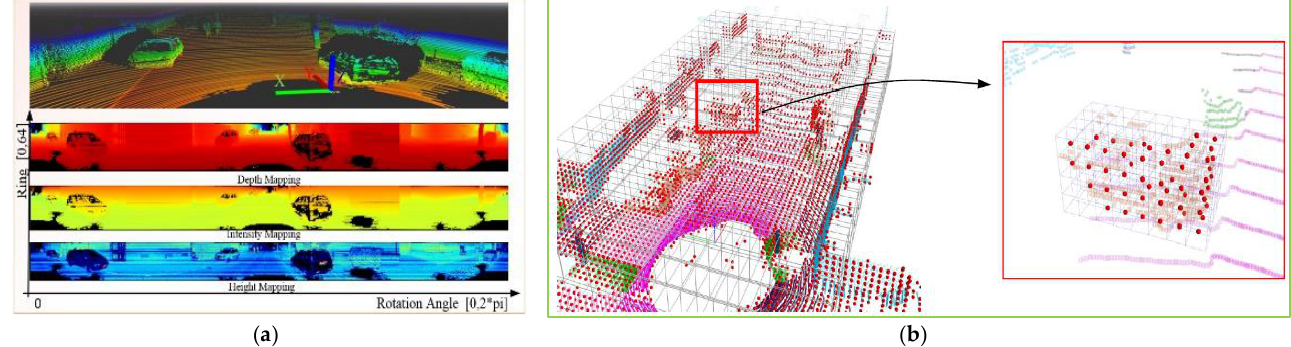
Figure 4. Representation of LiDAR point clouds. ( a ) Point cloud mapping. ( b ) Voxel-based [45]. The background modeling method based on a three-dimensional voxel aims to divide the laser point cloud into three-dimensional voxels according to the spatial coordinates of the points, as shown in Figure 4b, and establish a background model based on density statistics using multiple point cloud frames, and then discriminate the background voxels and the foreground voxels according to the point density changes in each voxel [46–49]. In addition, Wu et al. [50] proposed a variable-dimension background filtering method, which uses a dynamic matrix to store the locations of background points, and identifies background points according to the number of neighboring points and the distance between the points in the current frame and the aggregation frames. This method uses a frame-by-frame update instead of multi-frame spatial aggregation to construct and update the background, which greatly reduces the amount of calculation for background point cloud extraction. Zheng et al. [37] used the background difference method in image processing to filter the background of the roadside LiDAR point cloud data. The above methods generally use multi-frame aggregation to filter background points by summarizing the farthest distance value, average value, point density, and other features. Because the threshold parameters mainly depend on the experience of engineers, most methods lack transferability. In addition, none of the above methods can handle scenes in which the foreground object is stationary for a period of time. Wang et al. [51] established a Gaussian background model with the average height and number of points as parameters